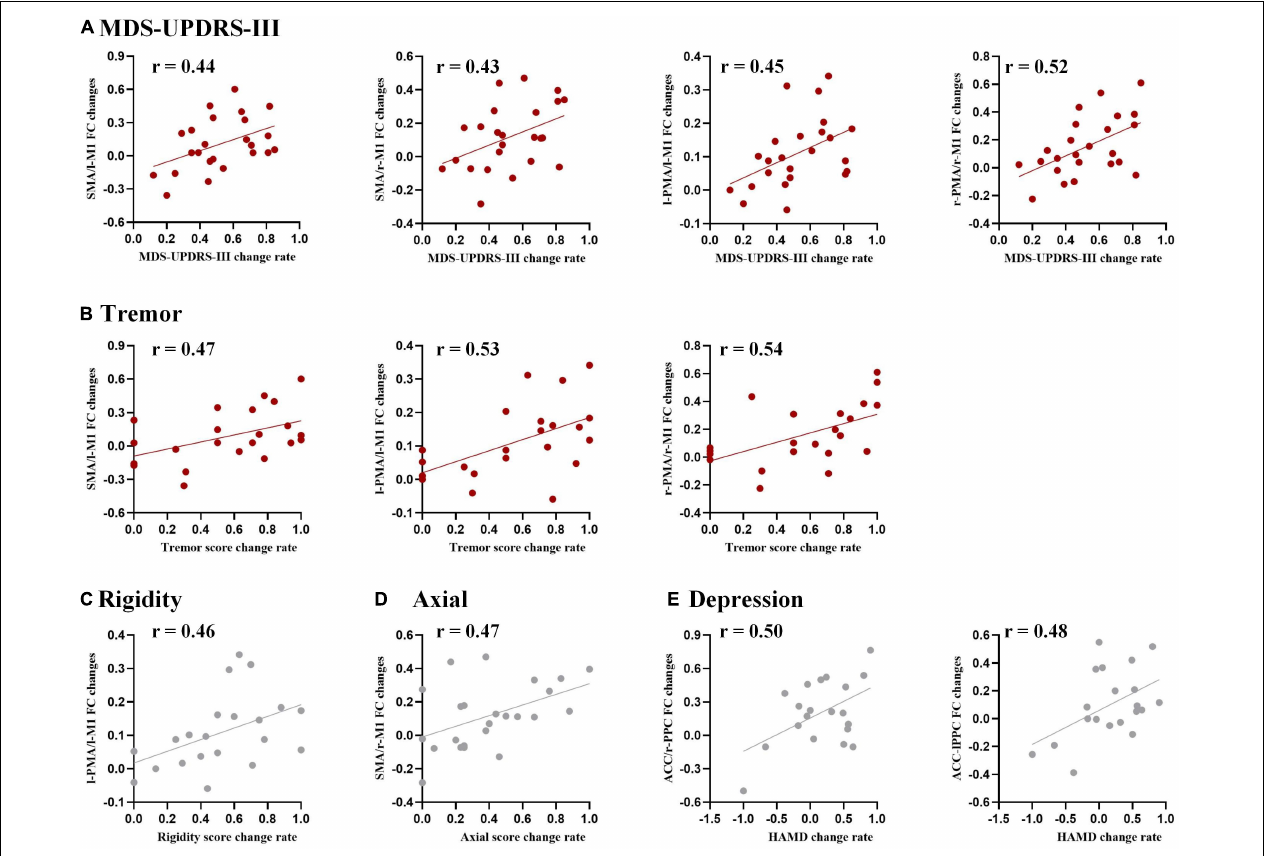
FIGURE 5 | Correlation analysis between functional connectivity changes and DBS improvements for (A) Movement Disorder Society Unified Parkinson’s Disease Rating Scale part III (MDS-UPDRS-III), (B) tremor, (C) rigidity, (D) axial, and (E) the Hamilton Depression scale (HAM-D). The threshold was set to uncorrected P < 0.05. Results surviving to FDR correction were shown in